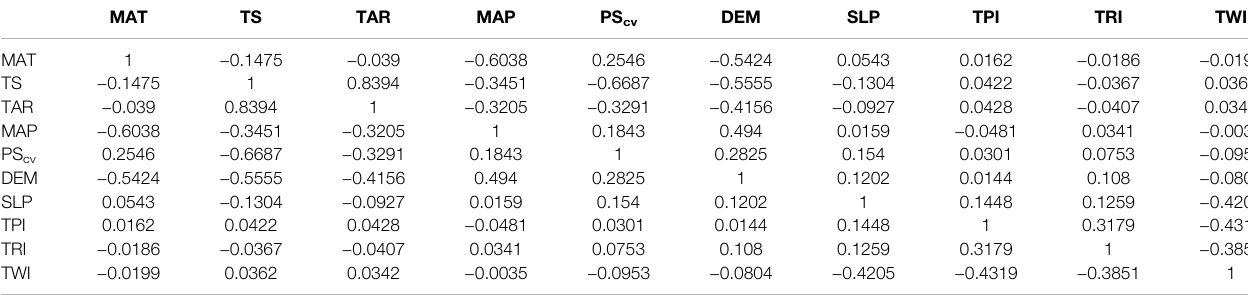
TABLE 3 | Results of Pearson ’ s test for statistical collinearity (variables r 2 > 0.8 were removed). MAT TS TAR MAP